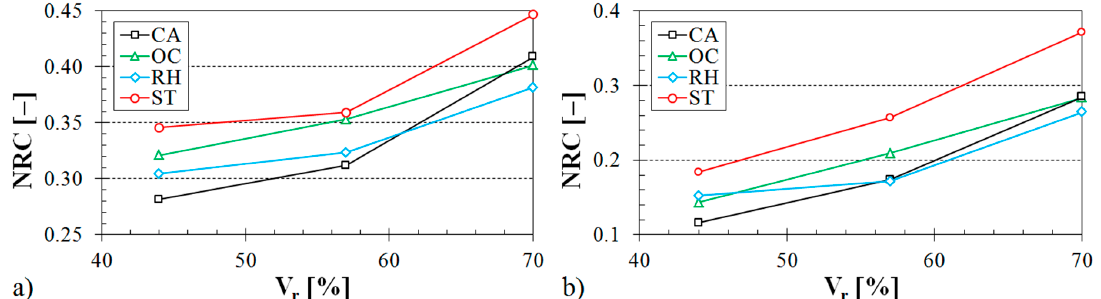
Figure 14. Influence of the 3D-printed ABS material structure on the noise reduction coefficient vs. volume ratio for the investigated ABS samples: ( a ) sample thickness t = 3 cm, air space size a = 10 cm; ( b ) sample thickness t = 1 cm, air space size a = 4 cm. Materials 2020 , 13 , x FOR PEER REVIEW